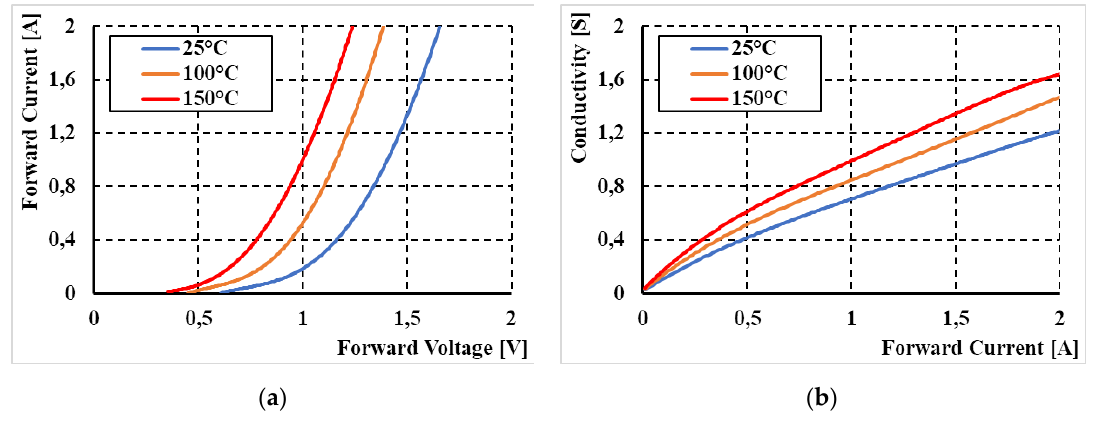
Figure 7. ( a ) V-A Characteristic of US1MHE3 diode; ( b ) Conductance Characteristic of US1MHE3